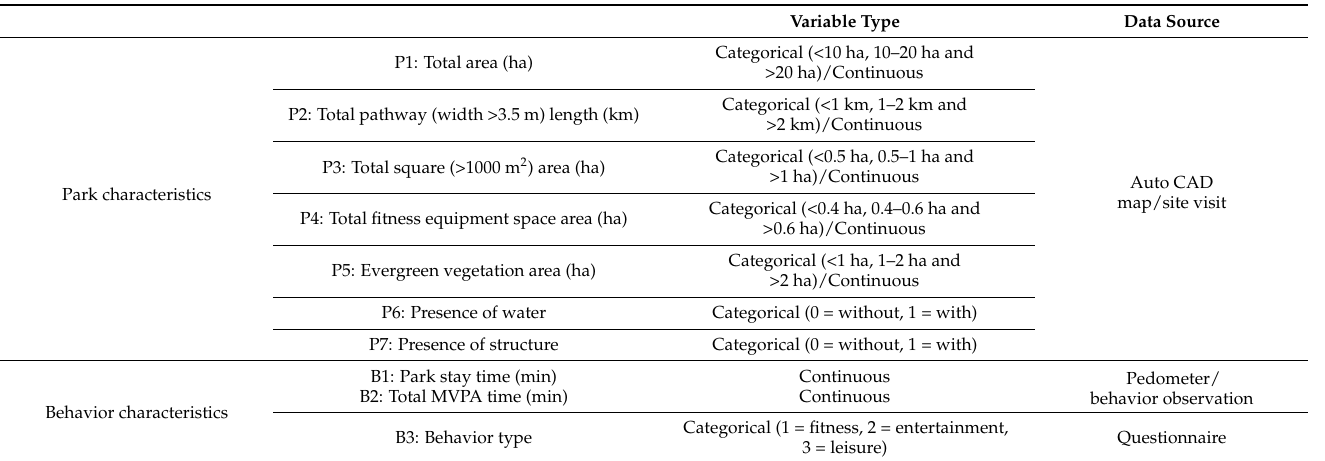
Table 2. Park design characteristics and behavior